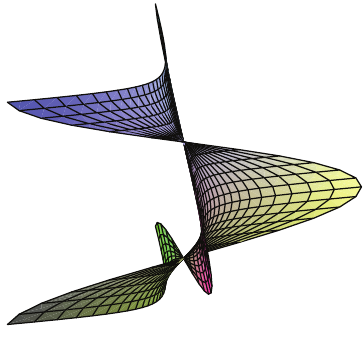
Figure 2: The catenoid of the 2nd kind.